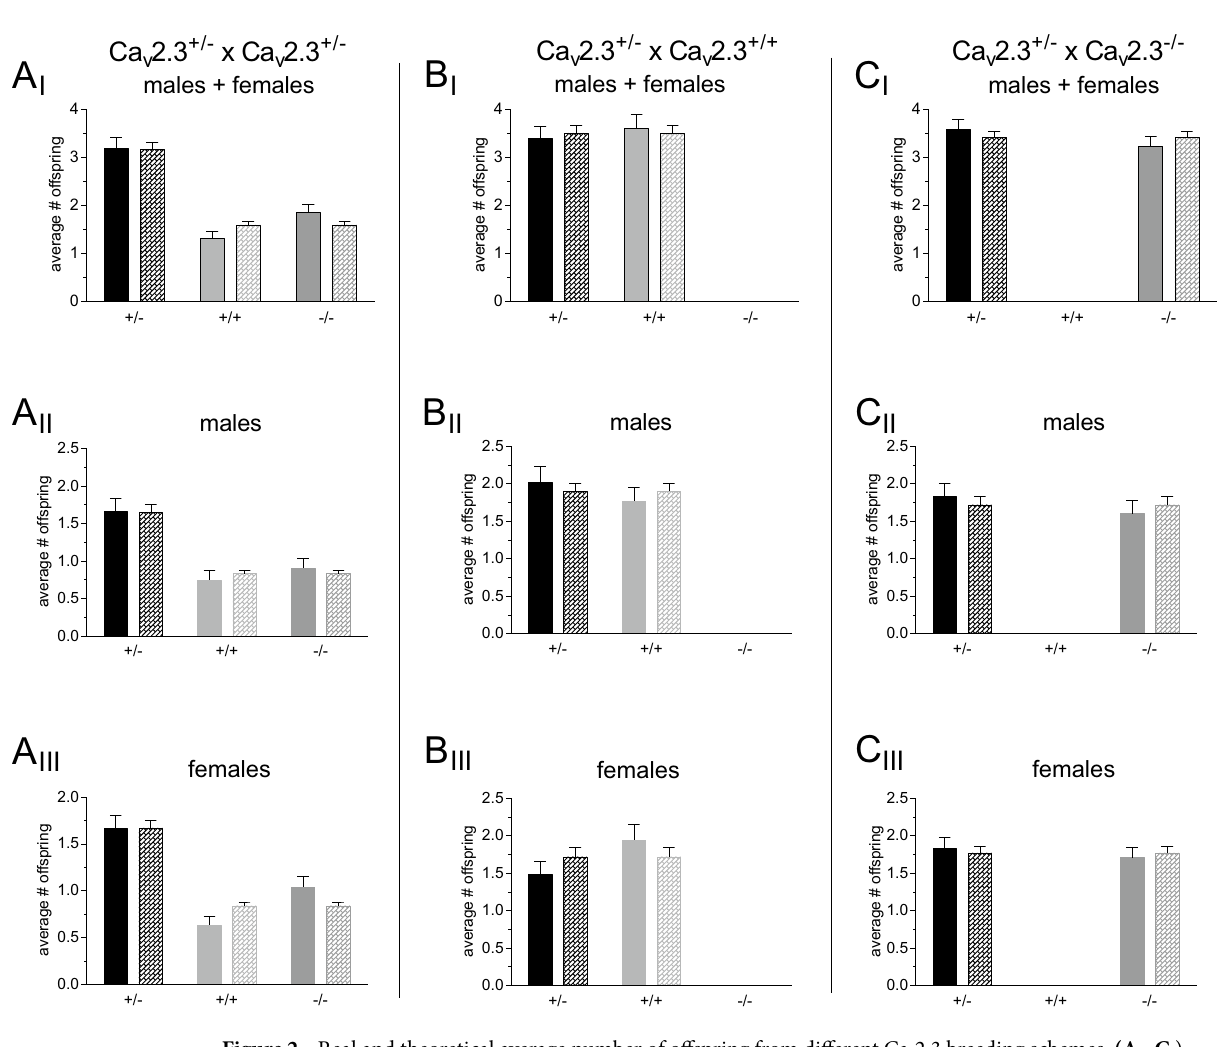
Figure 2. Real and theoretical average number of offspring from different Ca v 2.3 breeding schemes. (A I –C I ) Breeding results for both sexes using a Ca v 2.3 +/− × Ca v 2.3 +/− , Ca v 2.3 +/− × Ca v 2.3 +/+ and Ca v 2.3 +/− × Ca v 2.3 −/− breeding scheme. In addition, these data were analyzed separately for male offspring ( A II –C II ) and female offspring ( A III –C III ). Plain bars indicate real average offspring number, patterned bars indicate the theoretical average offspring number based on the Mendelian